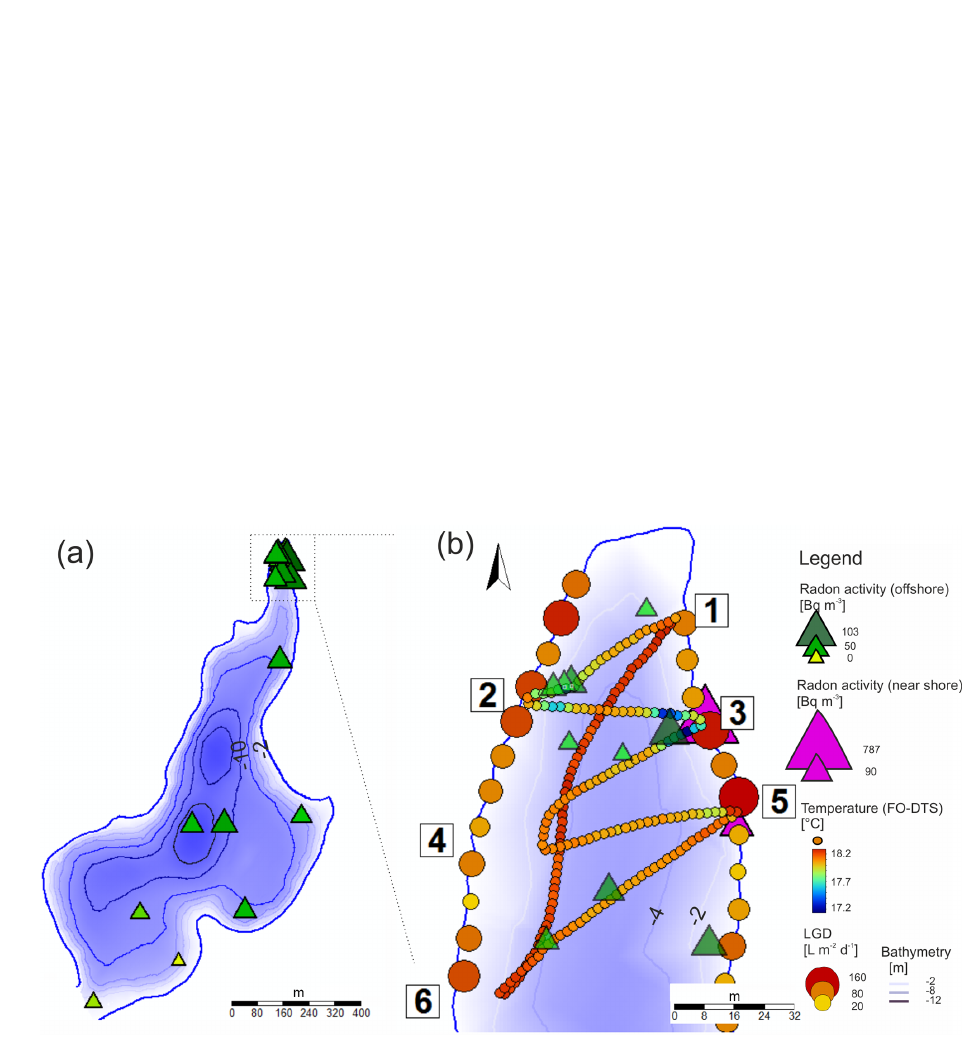
Figure A1. Radon activities measured in September 2013 and August 2014. LGD rates along the shoreline were derived from VTPs measured in June 2012. The DTS-derived temperature anomalies and the LGD rates along the shoreline are given for